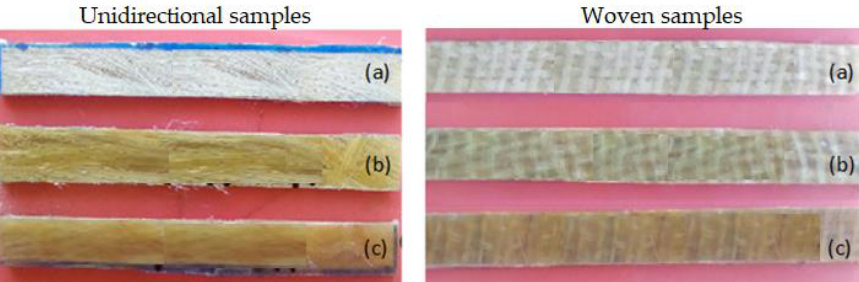
Figure 2. Unidirectional (L) and woven orientation (R) types of (a) untreated; (b) 5% NaOH-treated; and (c) 10% NaOH-treated E/S hybrid composites.